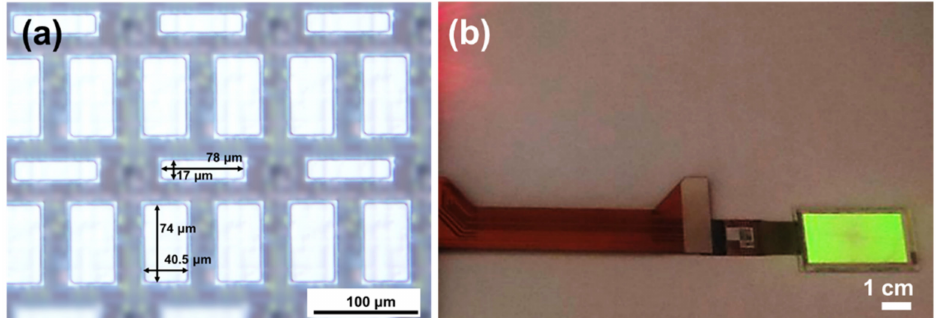
Figure 7. ( a ) Optical microscopic image of the AM TFT backplane employed in this study. The TFT backplane provided two different device sizes (17 × 78 µ m 2 and 74 × 40.5 µ m 2 ), as obtained from a commercial production line. ( b ) Photograph of 1.49 inch top-emitting AMQLED device array (number of device or sub-pixels = 86,400) operated at 5 V. An LTPS-TFT backplane with a 7T1C pixel circuit design was used to drive the AMQLED